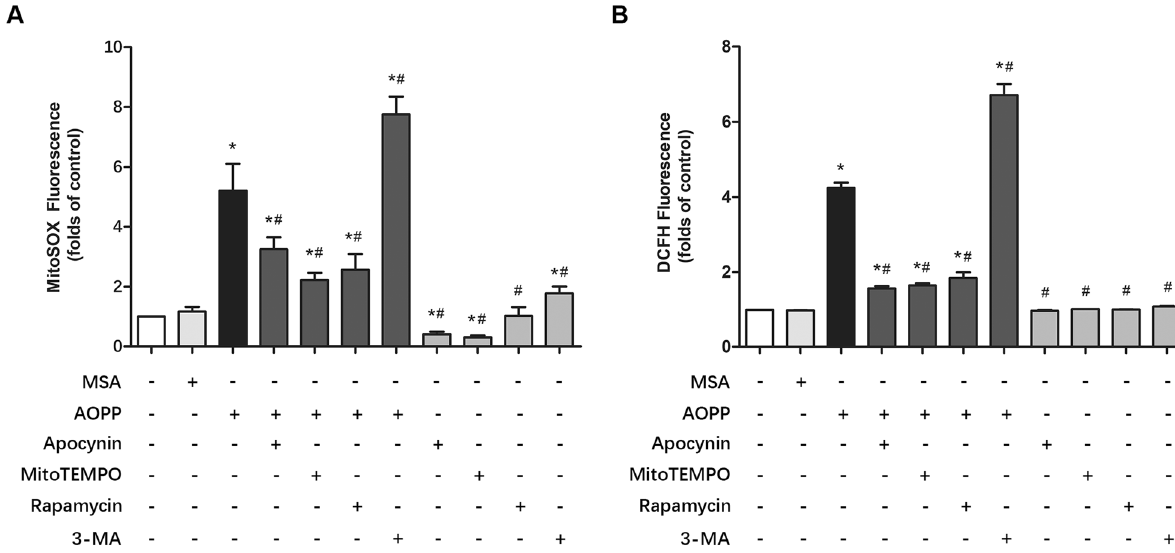
Fig. 1 AOPPs induced mtROS production in MC3T3-E1 cells. A MitoSOX results showed that AOPPs (200 μ g/mL) signi fi cantly increased mtROS levels in MC3T3-E1 cells. Pretreatment with apocynin, MitoTEMPO or rapamycin signi fi cantly reduced AOPP-induced mtROS production. Apocynin or MitoTEMPO alone also decreased mtROS levels in MC3T3-E1 cells, while rapamycin alone had no signi fi cant effect on mtROS levels. However, 3-MA not only elevated the mtROS level when administered alone but also further increased AOPP-induced mtROS generation ( n = 6 for each group). B DCFH-DA results showed that the intracellular ROS production induced by 200 μ g/mL AOPPs could be decreased by pretreatment with apocynin, MitoTEMPO and rapamycin. 3-MA further increased the intracellular ROS generation induced by AOPPs. Apocynin, MitoTEMPO, rapamycin and 3-MA had no signi fi cant effect on intracellular ROS production compared to the control group ( n = 6 for each group). Data are presented as the mean ± SD. * P < 0.05 versus control, # P < 0.05 versus